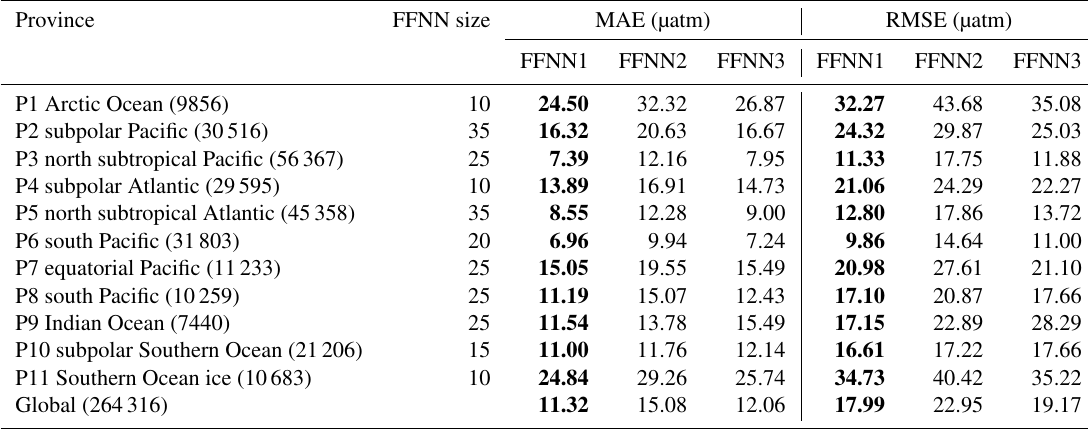
Table 4. Performance of p CO 2 prediction based on different predictors.